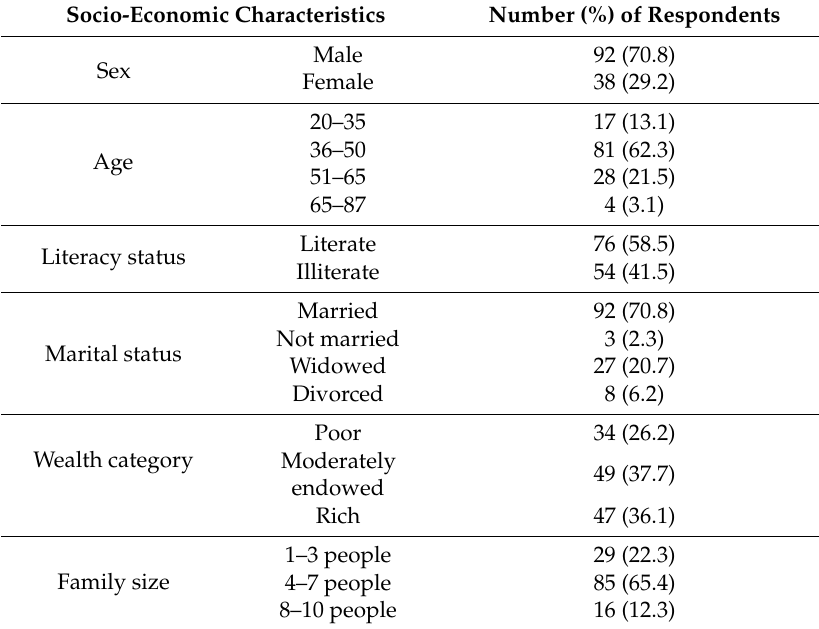
Table 1. Socio-economic characteristics of the 130 household heads interviewed in Assosa district, western Ethiopia.